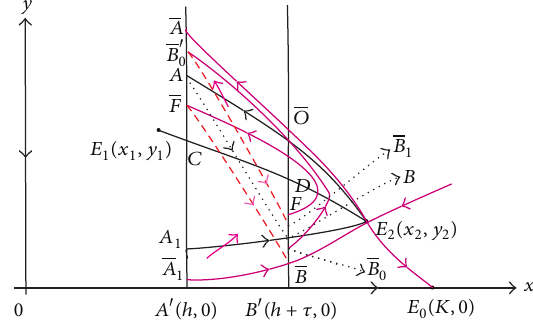
Figure 6: Illustration of homoclinic bifurcation of system (3) about 𝛿 .